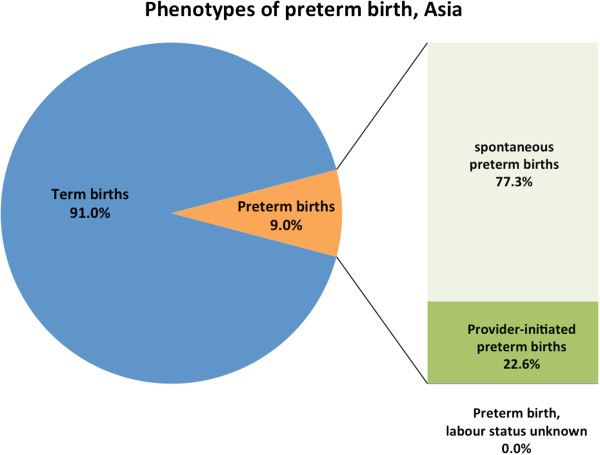
Phenotypes of preterm birth, Asian countries.